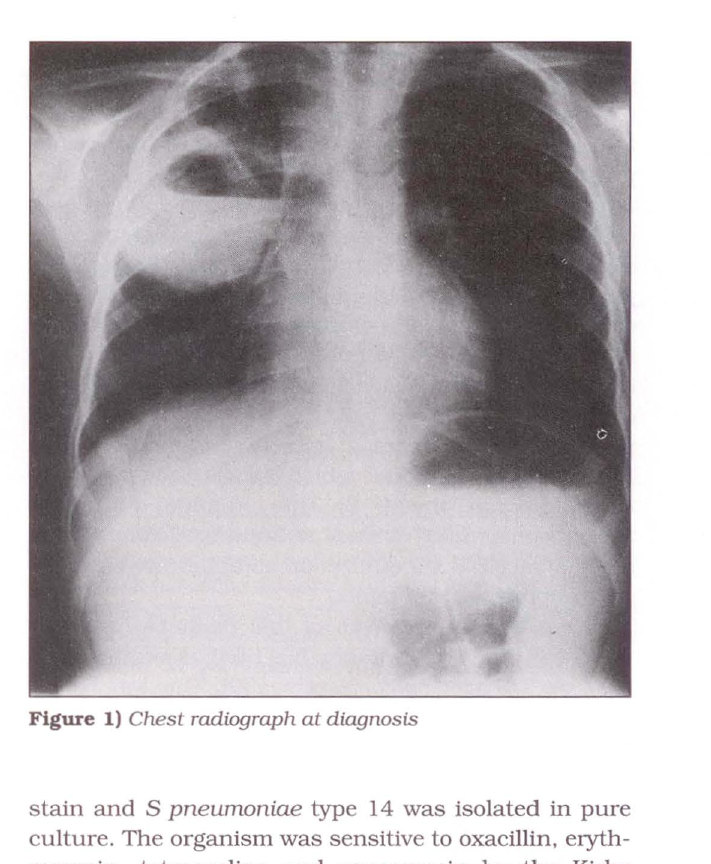
Figure 1) Chest radiograph at diagnosis